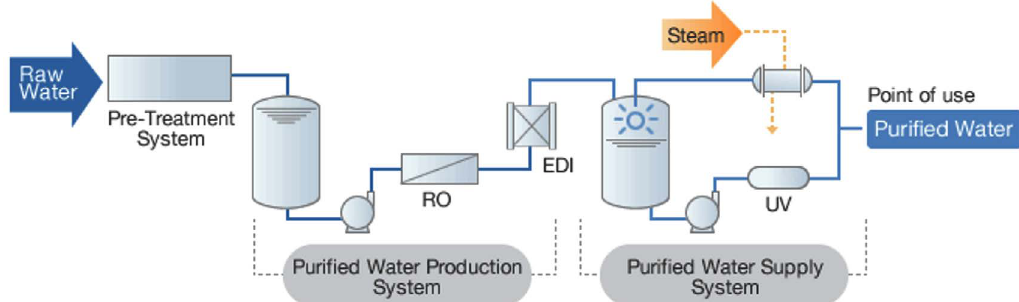
Fig. 1. Purified water process in pharmaceutical